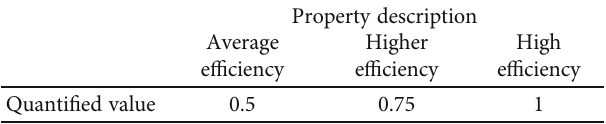
Table 5: Sta ff design e ffi ciency description quantitative table.